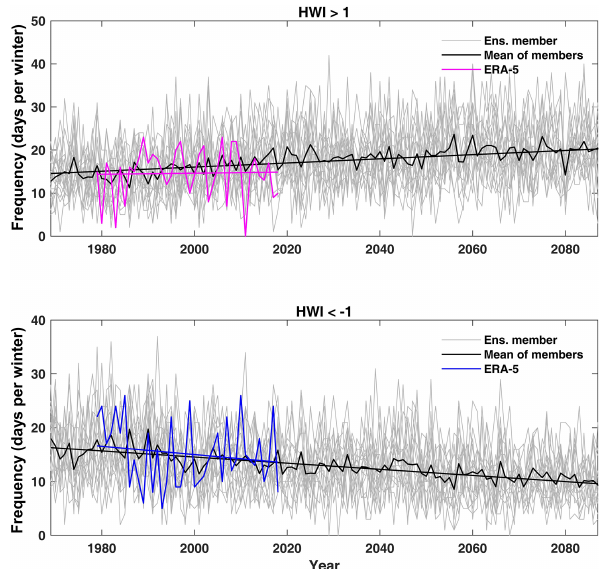
Figure 5. Frequencies of haze-conducive weather (HWI > 1, pink line) and clear weather (HWI < − 1, blue line) per winter from ERA-5 reanalysis (1979 to 2018). The year 1979 represents the pe- riod from 1 December 1979 to 28 February 1980, and so on. For each winter (DJF), we calculate the total number of days with HWI > 1 as a proxy for haze-conducive weather and HWI < − 1 as a proxy for clear weather conditions. Grey lines show frequencies from 16 individual PPE members and the black line shows the mean frequency calculated using all 16 PPE members for 1969–2087 un- der the RCP8.5 scenario. The linear trend is calculated using the line of best